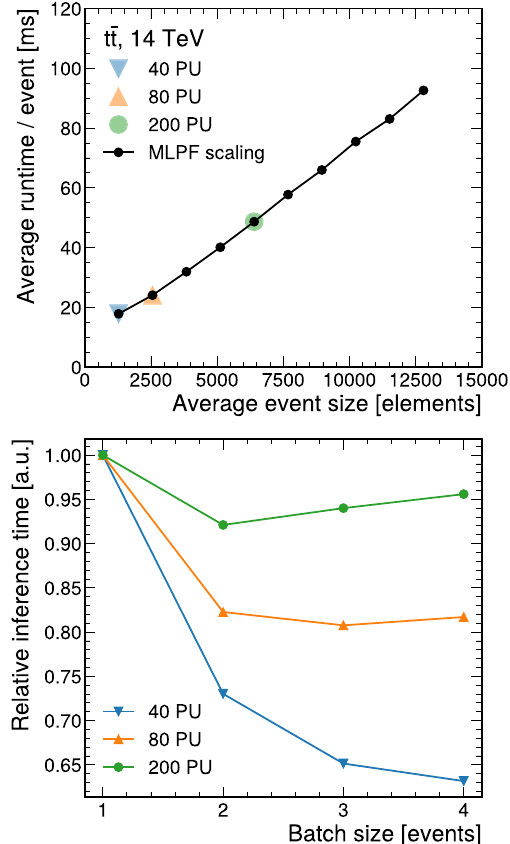
Fig. 11 Average runtime of the MLPF GNN model with a varying input event size (upper) and the relative inference time when varying the number of events evaluated simultaneously, i.e. batch size (lower), normalized to batch size 1. For a simulated event equivalent to 200 PU collisions, we see a runtime of around 50 ms, which scales approx- imately linearly with respect to the input event size. We see a weak dependence on batch size, with batching having a minor positive effect for low-pileup events. The runtime for each event size is averaged over 100 randomly generated events over three independent runs. The tim- ing tests were done using an Nvidia RTX 2060S GPU and an Intel i7-10700@2.9GHz CPU. We assume a linear scaling between PU and the number of detector